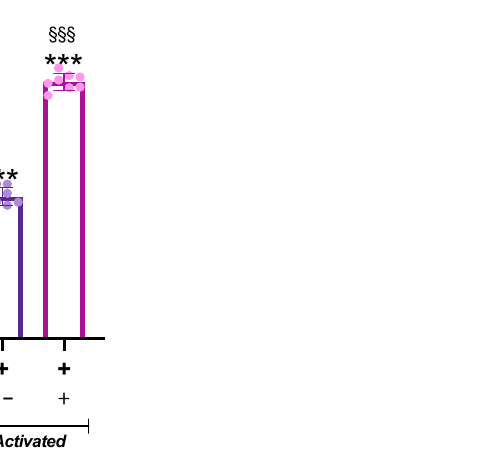
Figure 4. Effect of RSV on TNF- α release. TNF- α levels were measured in the supernatant from the NA, IL-2, and IL-2 + RSV samples. Data are expressed as mean ± SD. *** p < 0.001 vs. NA; §§§ p < 0.001 vs. IL-2 only.